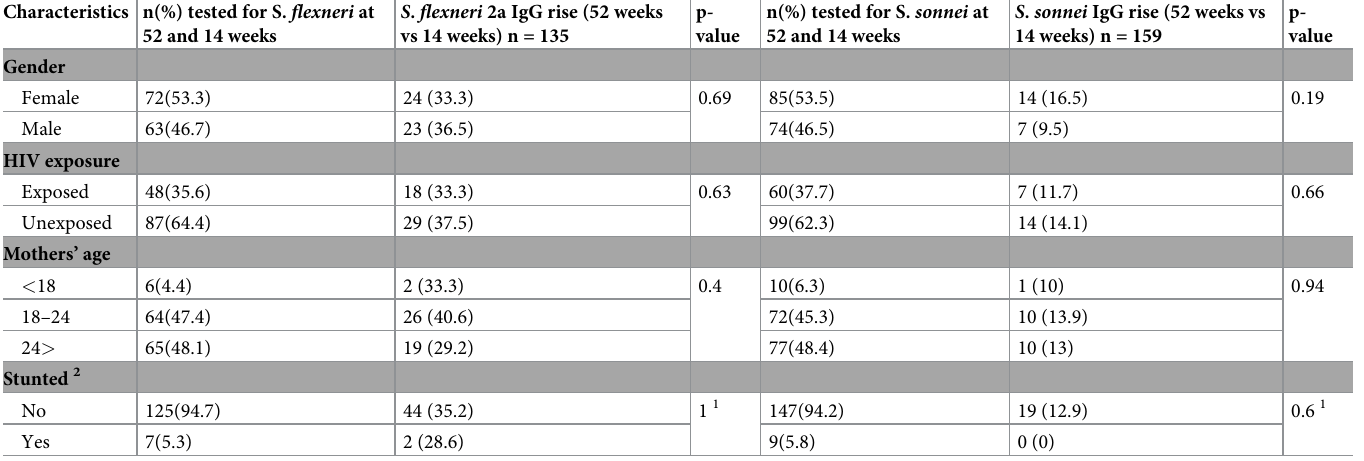
Table 2. Differences between children with a significant 4-fold rise in titre to S . flexneri 2a LPS and S . sonnei LPS by demographic characteristics. Characteristics n(%) tested for S. flexneri at 52 and 14 weeks